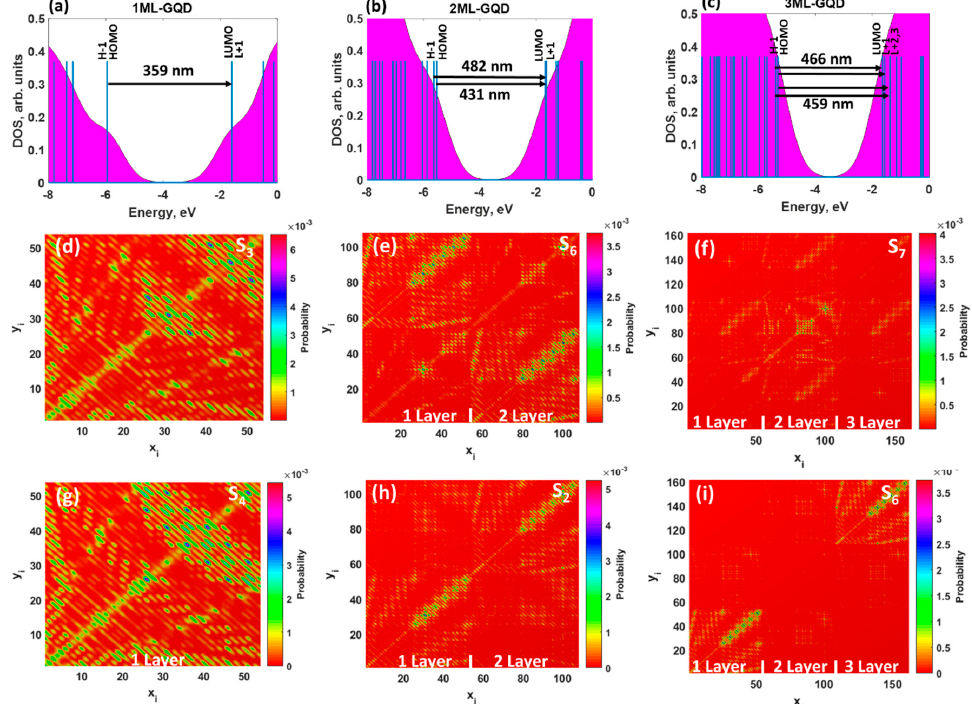
Figure 3. Density of states of the ( a ) monolayer, ( b ) bilayer, and ( c ) trilayer GQDs. Black arrows in ( a – c ) between the occupied and empty molecular orbitals represent electronic transitions (with highest values of the oscillator strengths) responsible for the optical absorption. Blue vertical lines denote the molecular orbitals. ( d – i ) Colour-filled maps of the transition density matrix of most probable ( d ) S 3 ← S 0 and ( g ) S 4 ← S 0 excited states in the monolayer GQDs; ( e ) S 6 ← S 0 and ( h ) S 2 ← S 0 in the bilayer GQDs; and ( f ) S 7 ← S 0 and ( i ) S 6 ← S 0 in the trilayer GQDs without interaction with elemental heavy metals. A colour scale bar is shown on the right of each contour plots.